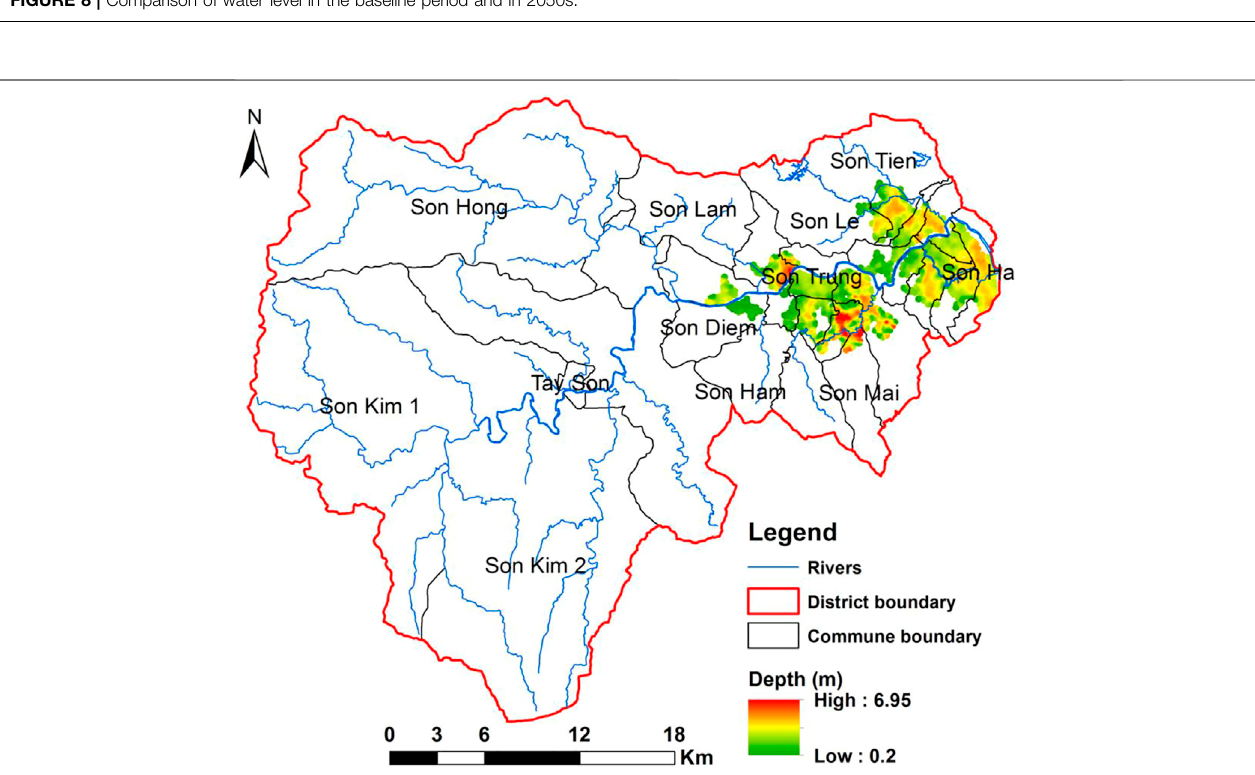
FIGURE 9 | The area of inundation in Huong Son district in the baseline